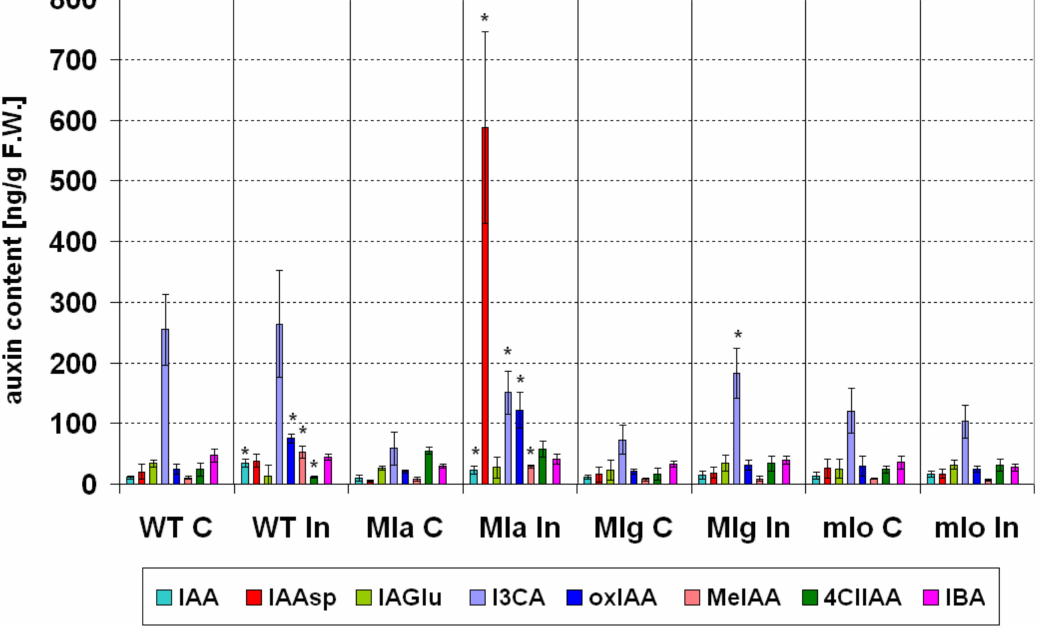
Figure 6. Changes in the contents of eight auxins in leaves of the susceptible barley cultivar Ingrid and its three near-isogenic lines Mla, Mlg, and mlo at seven days following powdery mildew inoculation (7 dpi). Abbreviations: C, control; In, powdery mildew inoculated; WT, wild type cultivar Ingrid. Investigated hormones: indole-3-acetic acid (IAA, active form), indole-3-acetyl-L-aspartic acid (IAAsp, degradation form), indole-3-acetyl-L-glutamic acid (IAGlu, degradation form), indole-3-carboxylic acid (I3CA, degradation form), oxindole-3-acetic acid (oxIAA, degradation form), indole-3-acetic acid methyl ester (MeIAA, precursor form), 4-chloroindole-3-acetic acid (4ClIAA, active form) and indole-3-butyric acid (IBA, precursor form). Means of five independent repetitions ± SD are shown. The symbol * shows significant di ff erences between inoculated and control leaves ( p < 5%, Student t test) for each genotype (and for particular auxin)